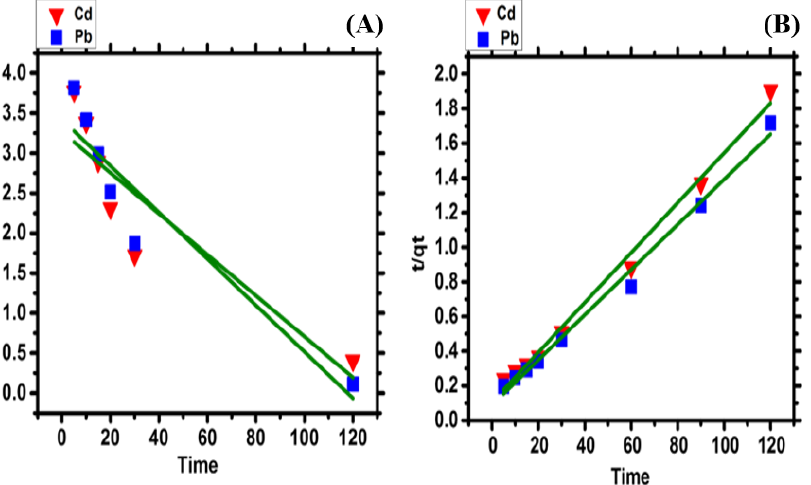
Figure 5. Kinetic study ( A ) pseudo-first order, ( B ) pseudo-second order, models for biosorption of Pb and Cd ions using dry Nostoc sp. MK-11 biomass.